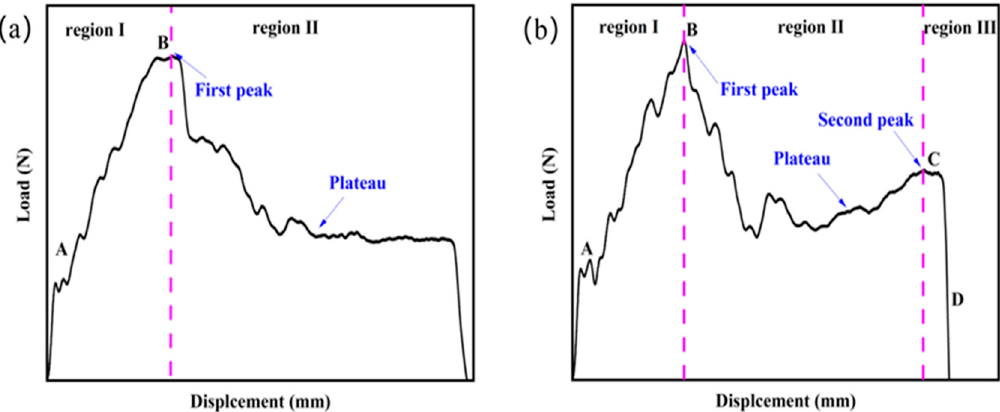
Figure 7. Typical load-displacement curves: ( a ) Mode A; ( b ) Mode B.